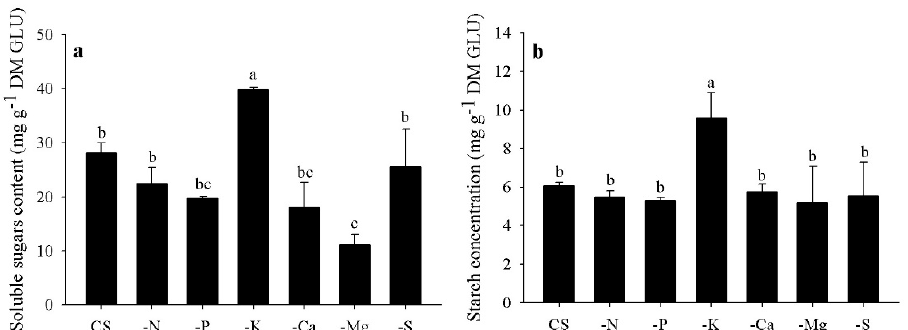
Figure 5. Soluble sugars ( a ) and starch ( b ) contents in shoots of broccoli ( Brassica oleracea var. italica L.) plants grown in a complete nutrient solution (CS) and under the omission of macronutrients (-N, -P, -K, -Ca, -Mg and -S). Mean values (column) followed by different letters indicate a statistically significant difference by the Tukey test ( p ≤ 0.05).